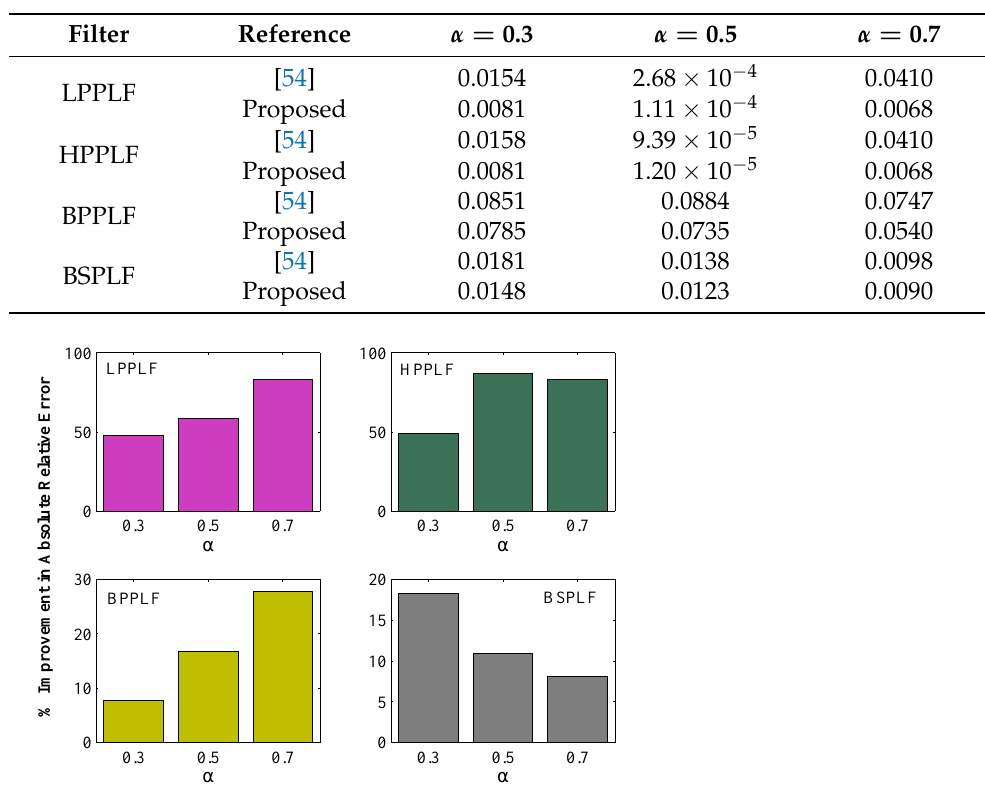
Figure 7. Percentage improvement in absolute relative error of the proposed PLFs with respect to